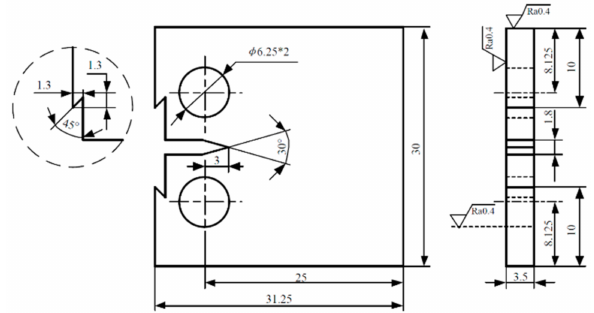
Figure 2. Dimensions of CT specimen (mm).